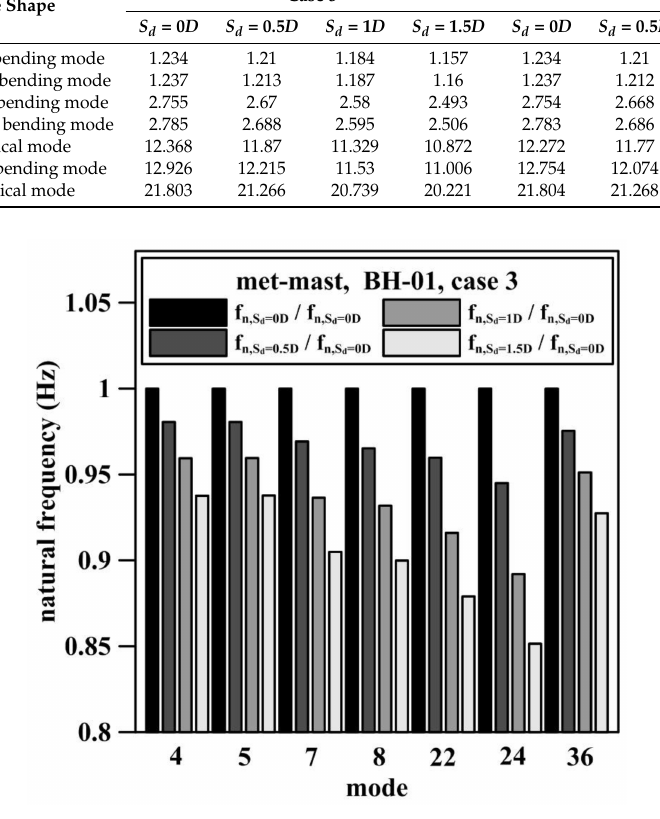
Figure 16. Natural frequency ratios of vibration modes—case